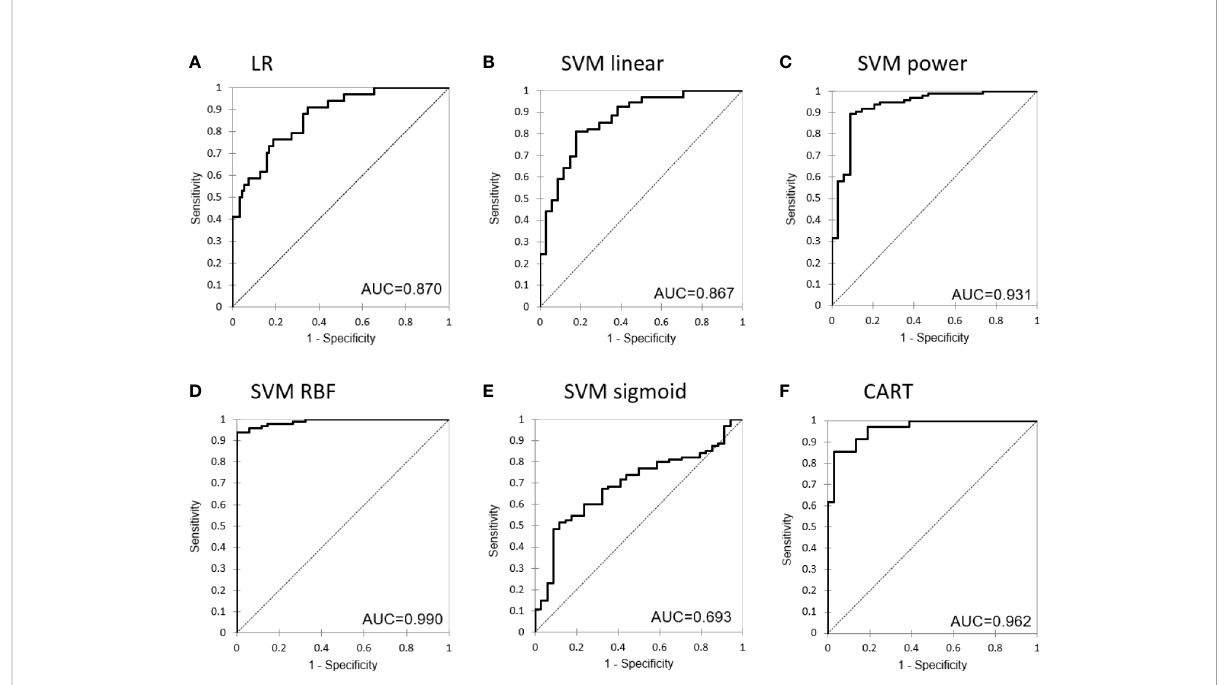
FIGURE 4 Receiver operating characteristic (ROC) curve for the different machine learning models: (A) Logistic Regression, (B) Support Vector Machine with linear kernel, (C) Support Vector Machine with power kernel, (D) Support Vector Machine with RBF kernel, (E) Support Vector Machine with sigmoid kernel and (F) Classi fi cation and Regression